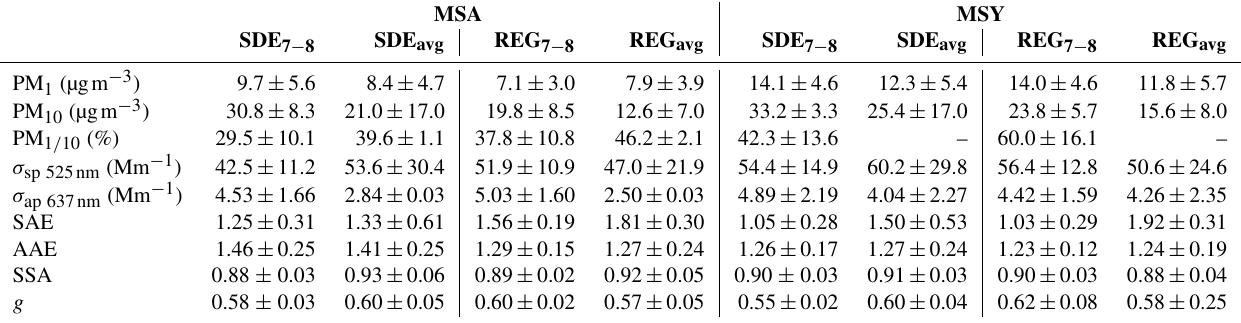
Table 2. Mean values of in situ surface PM 1 , PM 10 , PM 1 / 10 , σ sp 525nm , σ ap 637nm , SAE, AAE, SSA and g measured at the MSY and MSA stations during the SDE period of 7–8 July and the REG period of 14 and 16 July compared to the mean values typically measured (denoted by “avg”) during SDE and REG episodes as reported by Pandolfi et al. (2014a) and Ealo et al.